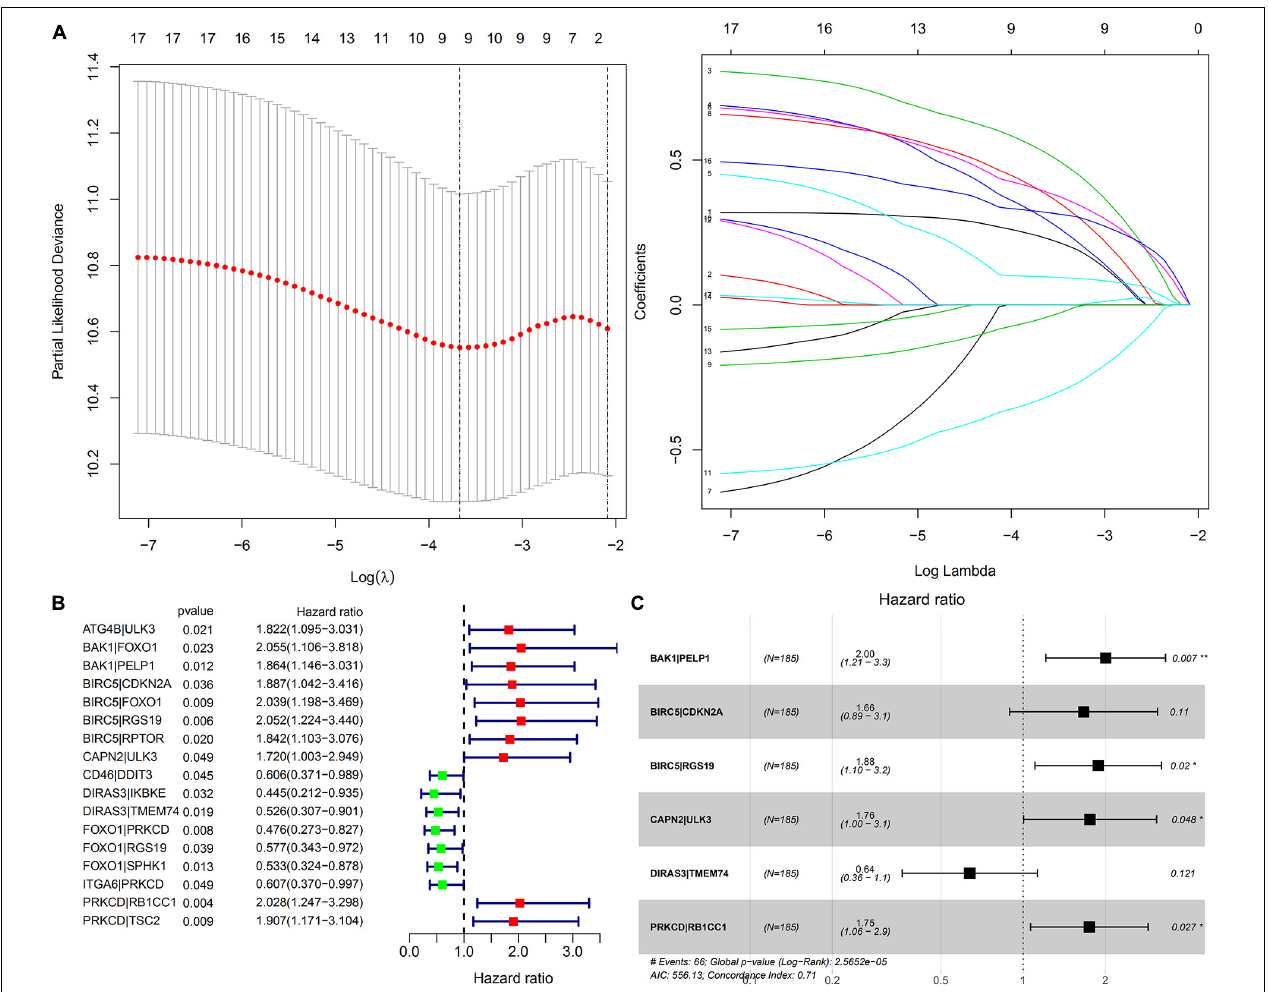
FIGURE 3 | Construction of a prognostic signature based on ARGP. (A) The Cross-Validation fit curve was calculated by lasso regression analysis. (B) The Forest plot represents the 17 OS-related ARGPs identified by Univariate Cox regression analysis. (C) The 6 ARGPs to construct the prognostic signature selected by Multivariate Cox regression analysis. P < 0.05 sets as the cutoff